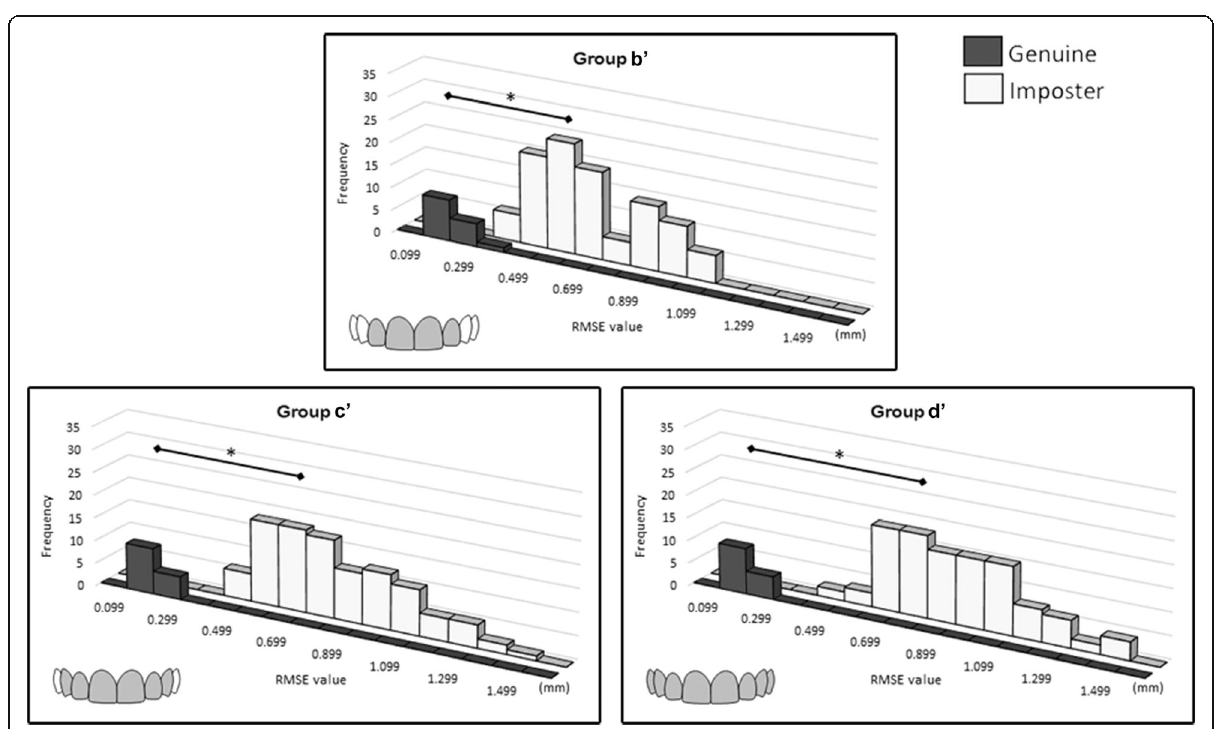
Fig. 9 The distribution pattern of root mean square errors (RMSEs) of the three-dimensional data for the genuine and imposter pairs in experiment 2. Labial surfaces from the right to the left second incisor ( b ′ ), the right to the left canine ( c ′ ), and the right to the left first premolar ( d ′ )